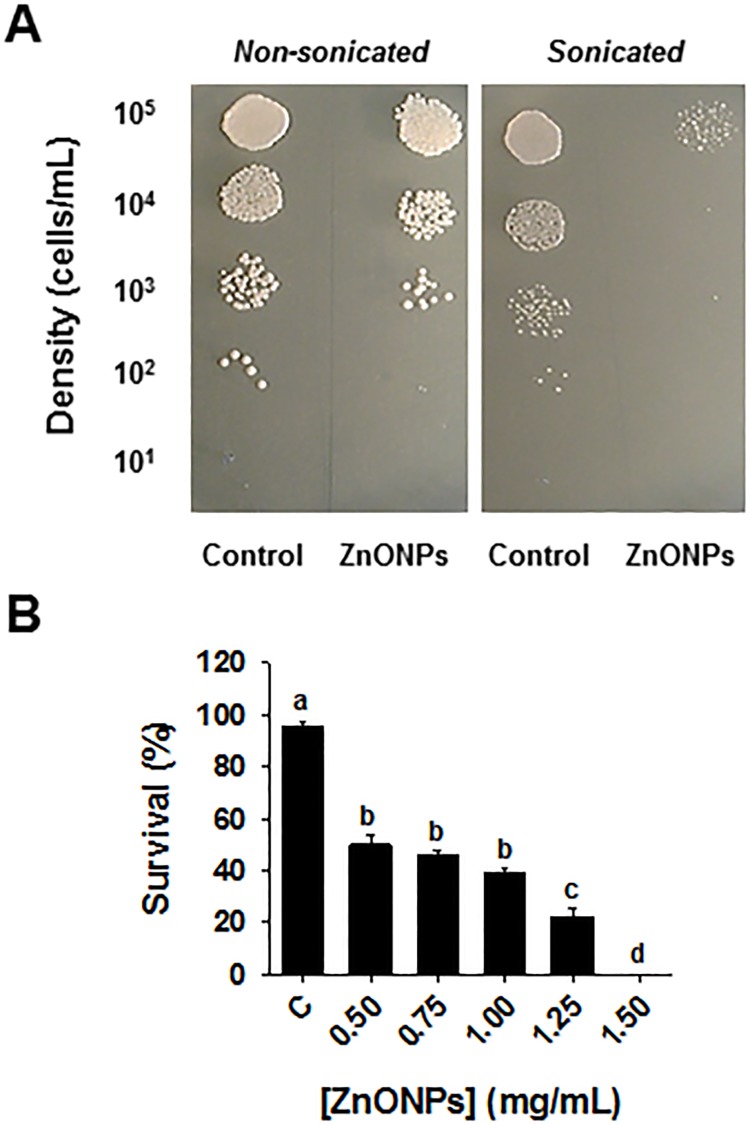
ZnONPs compromise cell wall integrity.(A) Cells were exposed to various concentrations of ZnONPs, subjected to mild sonication, diluted and then spotted onto YPD and compared to non-sonicated counterparts. (B) Cell survival rate (% survival sonicated/non-sonicated cells) was then quantified. Mean ± SEM are presented (n ≥ 3). Significant differences are indicated with letters.